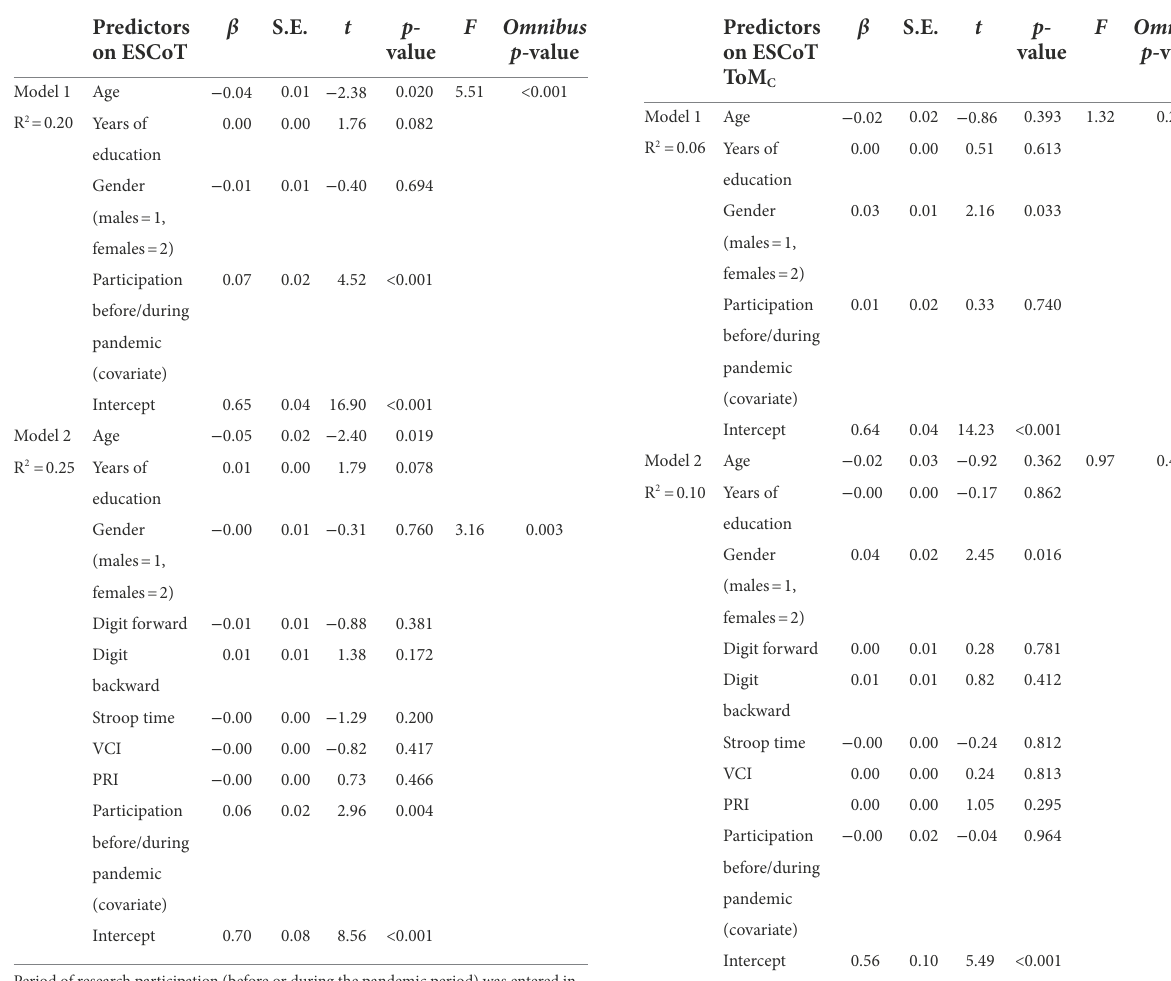
TABLE 4 Multiple regression results for predictors of ESCoT ToM C total score.